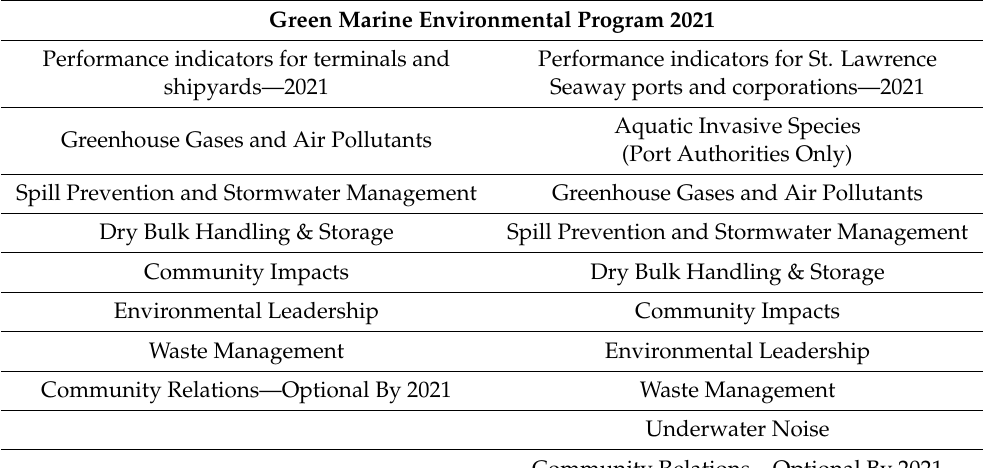
Table 1. Performance Indicators.